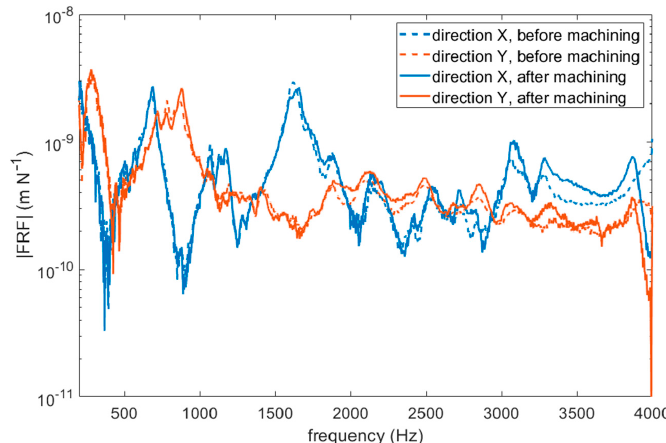
Figure 4. Workpiece FRF at directions X and Y for before and after machining tests.